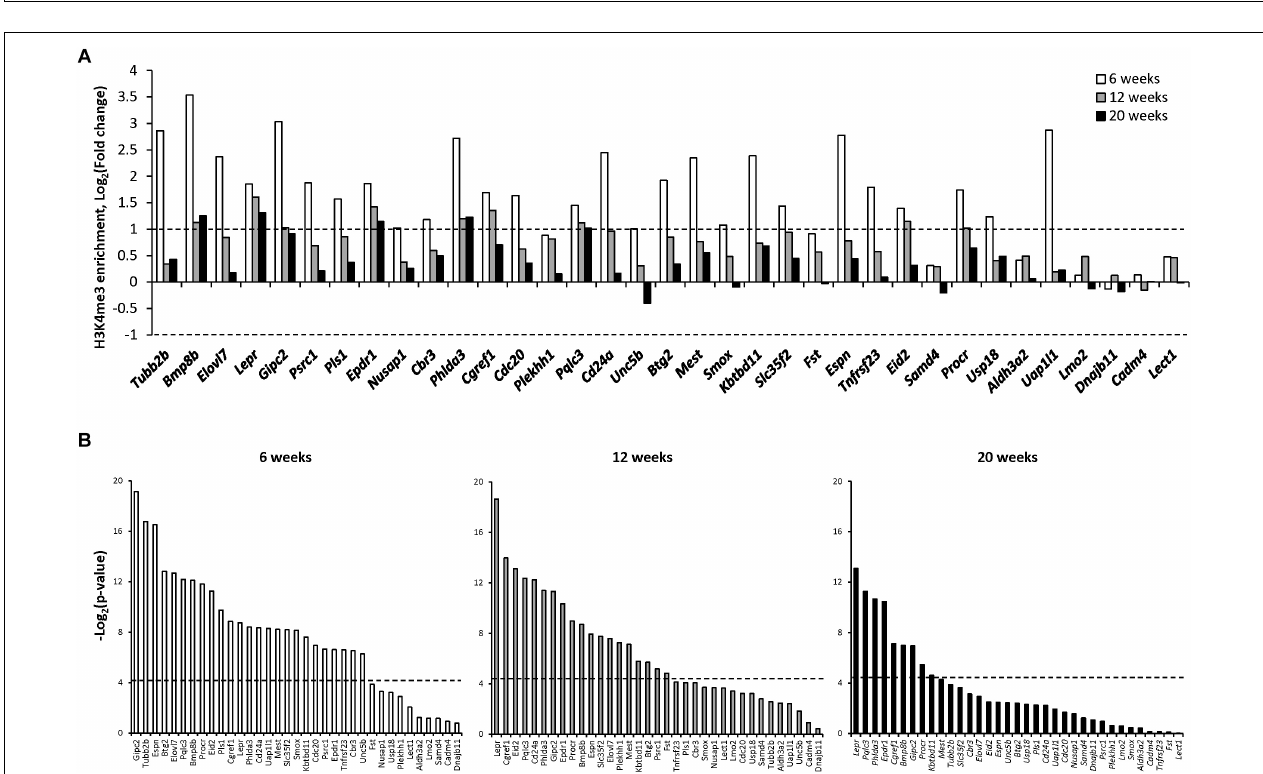
FIGURE 2 | Gene-specific histone H3K4 trimethylation in the livers of STAM mice during hepatocarcinogenesis. (A) The changes in the level of histone H3 lysine 4 trimethylation in the promoter region of selected genes at NAFL (6 weeks), NASH-fibrotic (12 weeks), and full-fledged HCC (20 weeks) stages of NASH-associated liver carcinogenesis. Dashed line indicates threshold level, which was selected as a twofold change comparing to control age-matched mice (Log 2 fold change = + 1 and − 1). (B) Pearson correlation P -value between gene expression and change in the promoter region histone H3 lysine 4 trimethylation in the livers of mice subjected to STAM hepatocarcinogenesis at 6, 12, and 20 weeks. Dashed line indicates the threshold level, which was selected as P = 0.05 (Log 2 P =